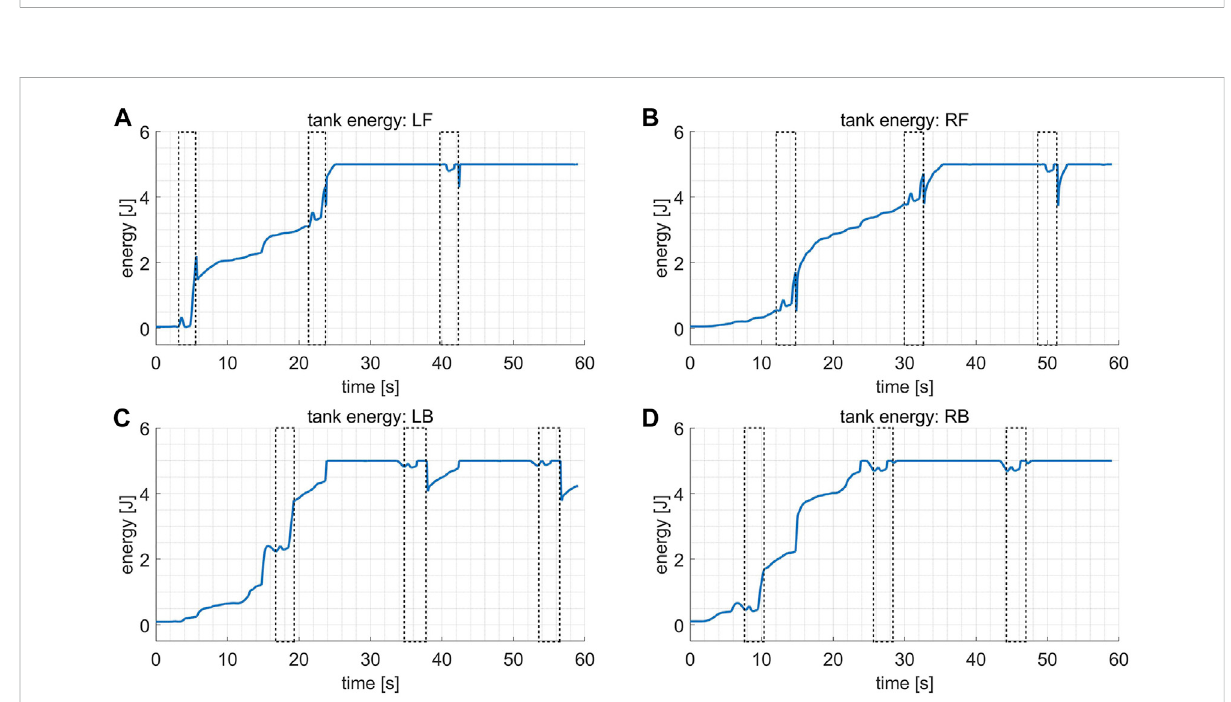
FIGURE 9 The plots of thetank energy in thevariable stiffness locomotion, where thedashed boxes indicate the swing phases. (A) Tank energy for the leg LF. (B) Tank energy for the leg RF. (C) Tank energy for the leg LB. (D) Tank energy for the leg RB.